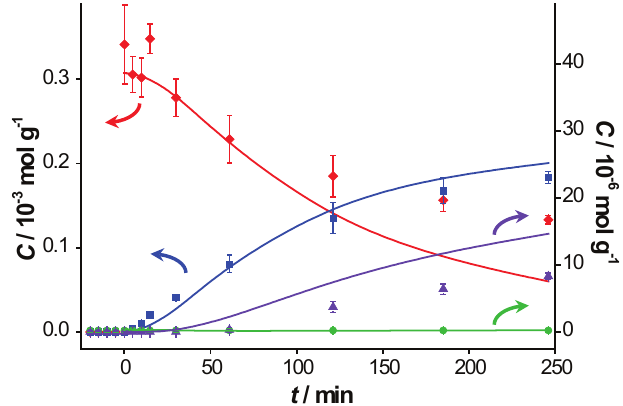
Figure 10. Catalyst performance in the presence of K acid. Concentration of ( ♦ ) benzyl alcohol, ( ■ ) benzaldehyde, ( ● ) benzoic acid and ( ▲ ) benzyl benzoate vs. reaction time for catalytic reaction over fresh AUROlite ™ where benzoic acid was introduced prior to the beginning of the reaction. Reaction conditions: T = 80 °C, 0.8 g AUROlite ™ , 3.04 g K × 10 − 6 mol·g − 1 , in 80 mL of toluene, 200 mL·min − 1 air flow. Concentrations are expressed in moles per unit mass of liquid in the reactor (mol · g − 1 ). The symbols with error bars are the experimental results and the lines represent the kinetic